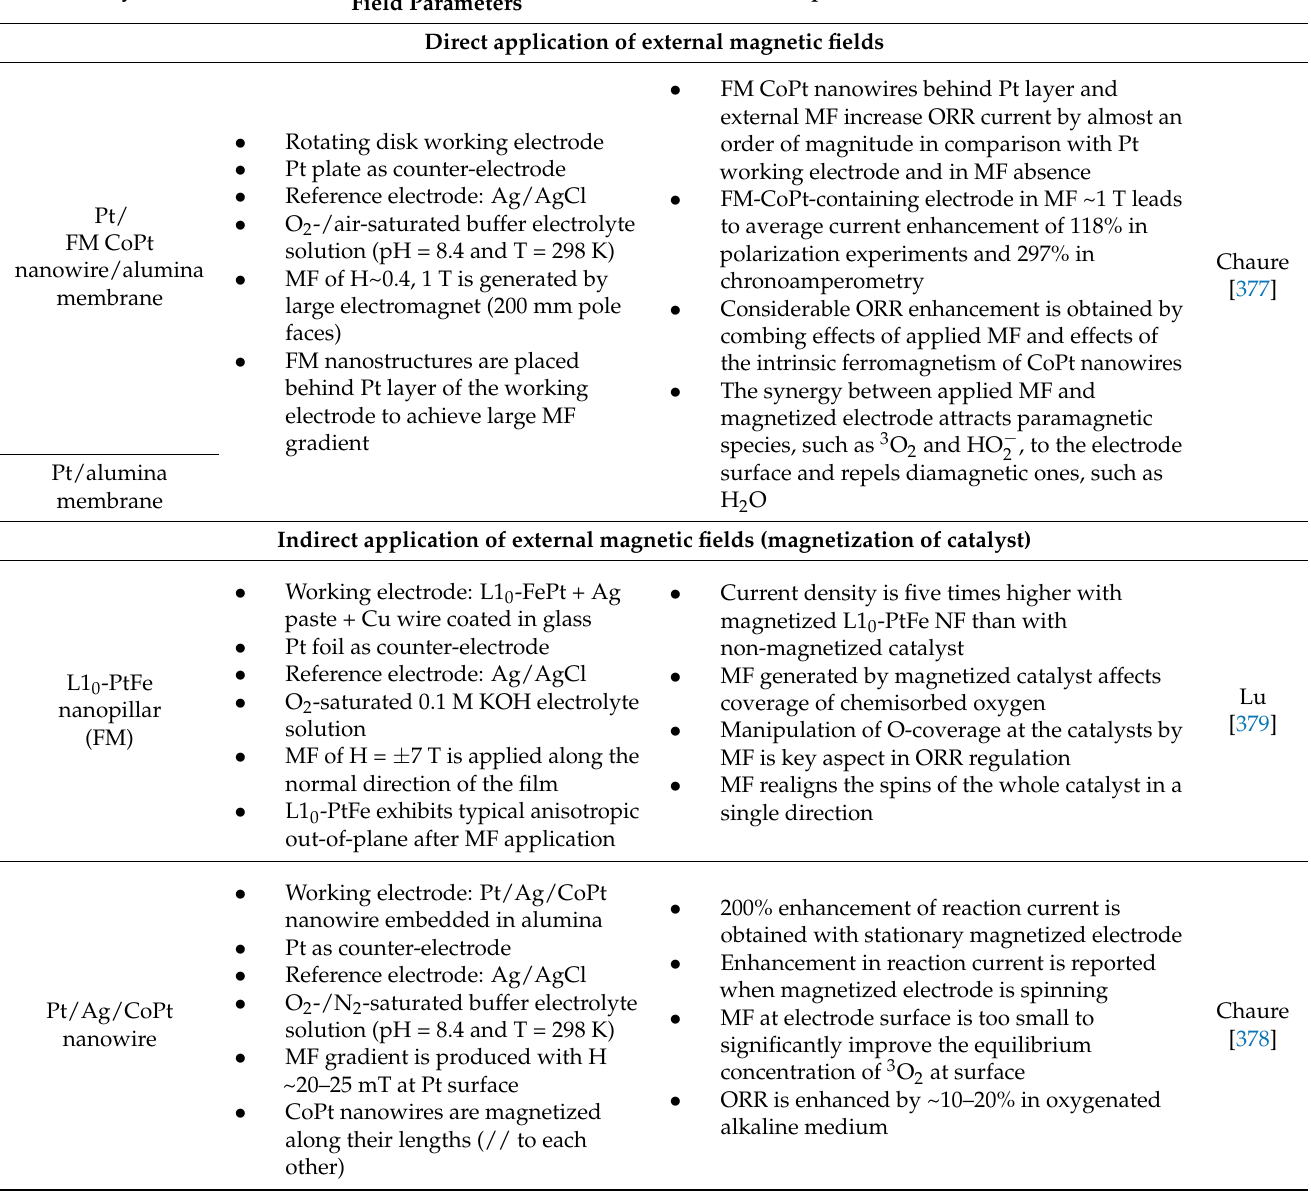
Table 6. Application of external magnetic field directly or indirectly, through the magnetization of the catalyst, for ORR catalysts. MF and FM stand for magnetic field and ferromagnetic, respectively.